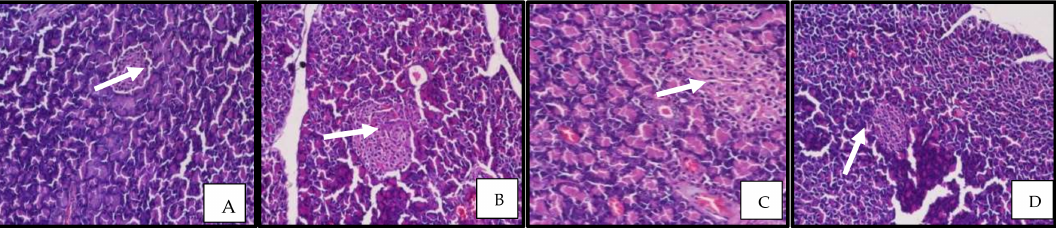
Figure 12. Representative photomicrographs illlustrating pancreatic tissue sections stained with H and E among various experimental groups. ( A ) Normal control: organized pattern and normal architecture of islet cell. ( B ) Diabetic control: damaged islets of Langerhans and degeneration in the pancreas portion. ( C ) Rosinidin-10: improved pancreatic histology, but minor pancreatic cell congestion. ( D ) Rosinidin-20: marked improvement in pancreatic histology. Arrows indicate islets of